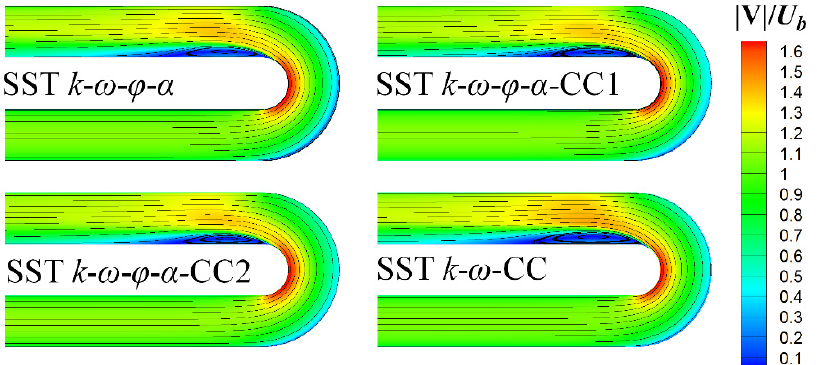
Figure 6. The velocity magnitude contours predicted by different turbulence models for the 2D U-turn duct flow.